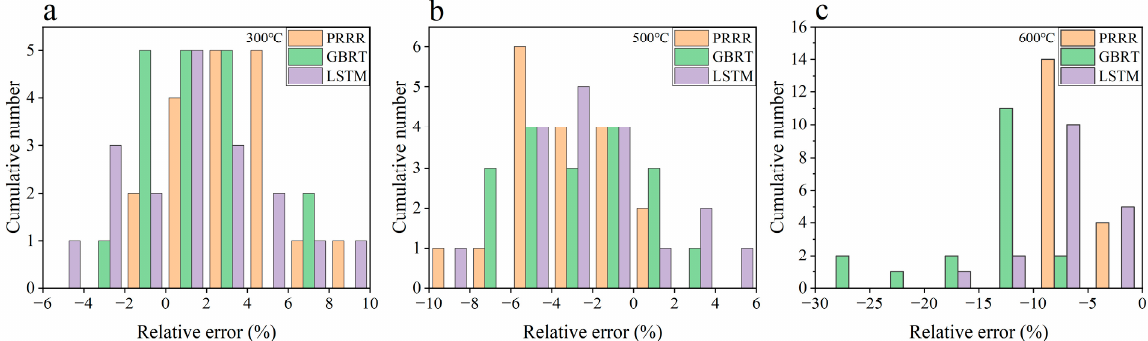
Figure 8. Relative errors of the predicted results to the experimental data for the different machine learning models in Figure 7. ( a ) 300 °C; ( b ) 500 °C; ( c ) 600 °C. The range of relative errors is the same between the same numbers on the horizontal axis.